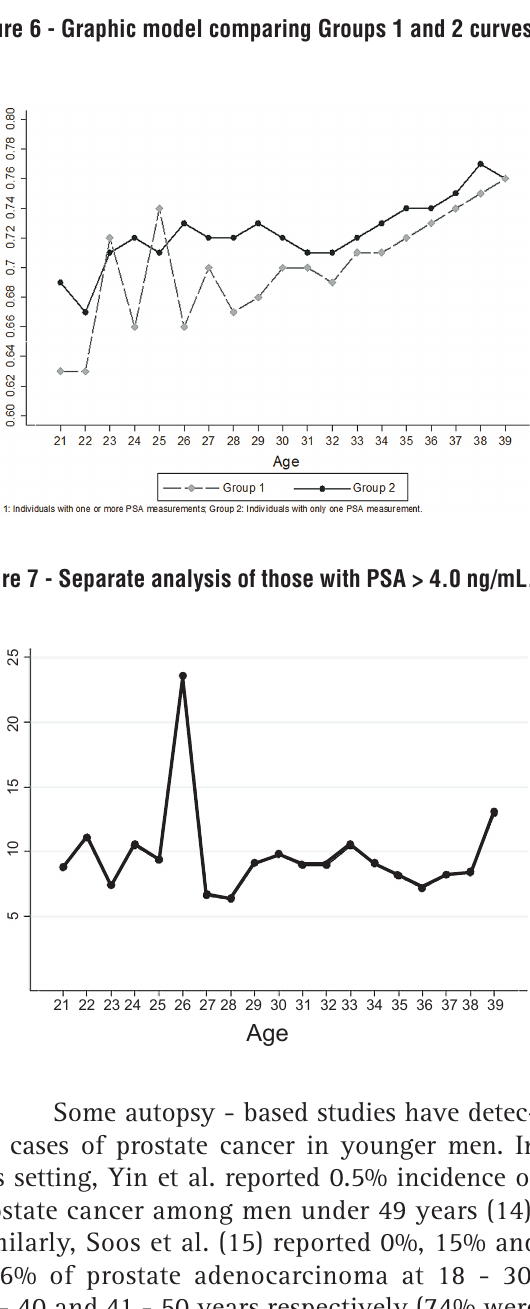
Figure 6 - Graphic model comparing Groups 1 and 2 curves.